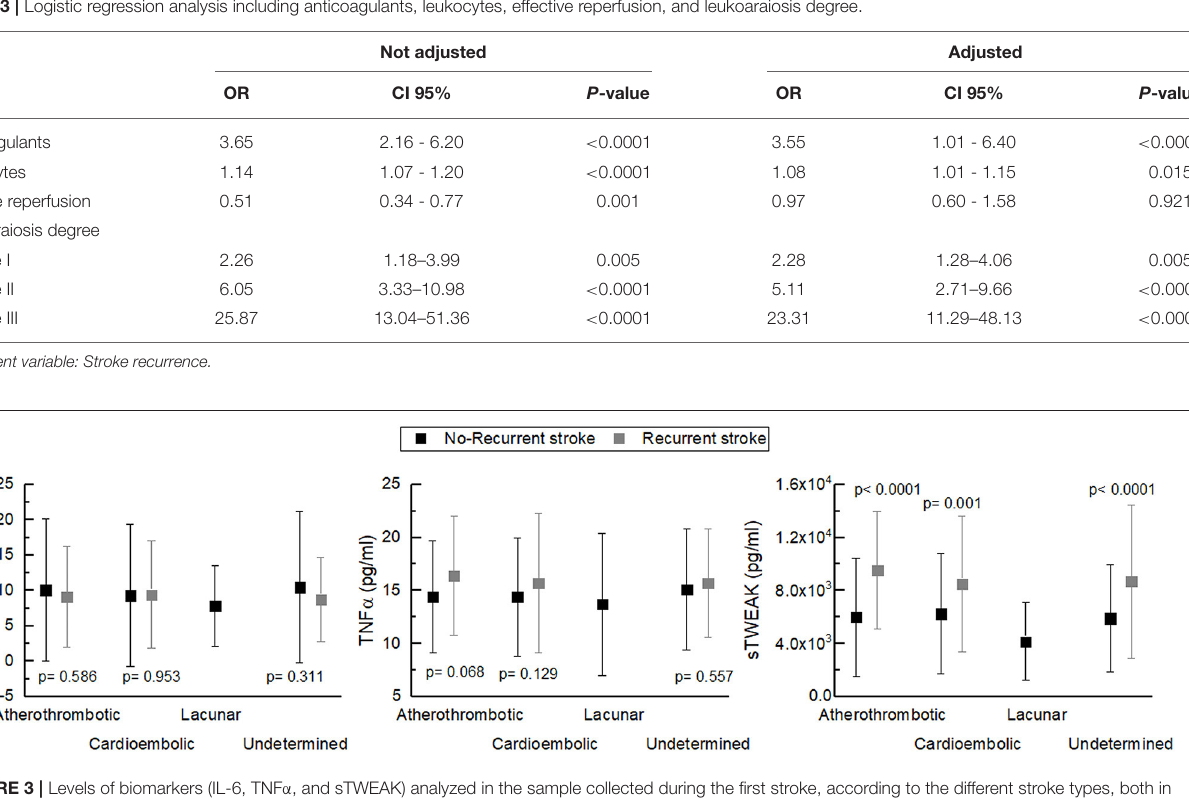
FIGURE 3 | Levels of biomarkers (IL-6, TNF α , and sTWEAK) analyzed in the sample collected during the first stroke, according to the different stroke types, both in those who did not recurred and in those who subsequently